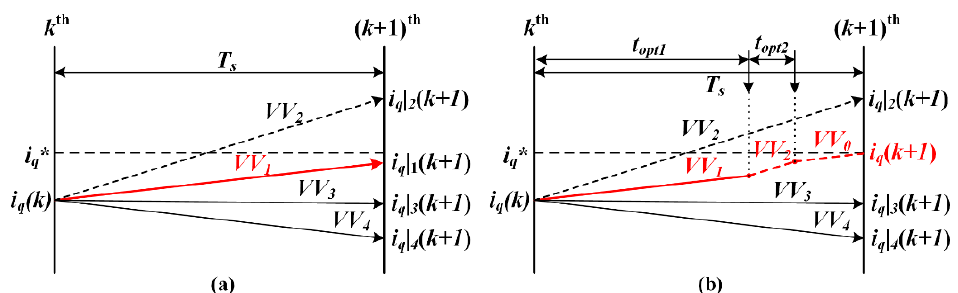
Figure 6. Virtual vector selection of MVV-MPC. ( a ) The selection of the first virtual vector; ( b ) the selection of the second vector and zero vector.